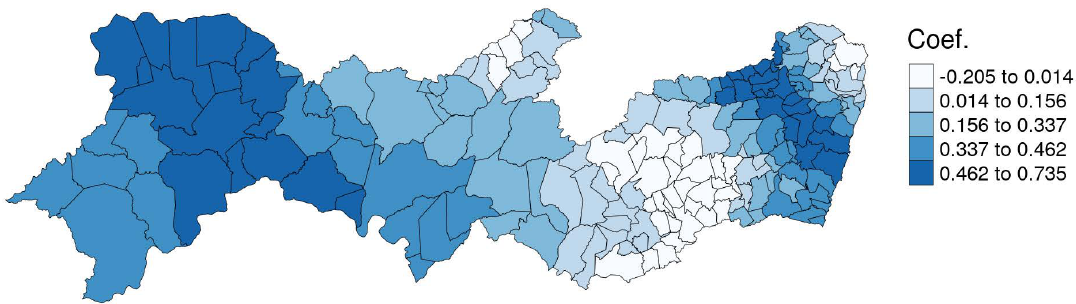
Figure 10. Distribution of the local coe ffi cients of the GWR model (GINI Index).